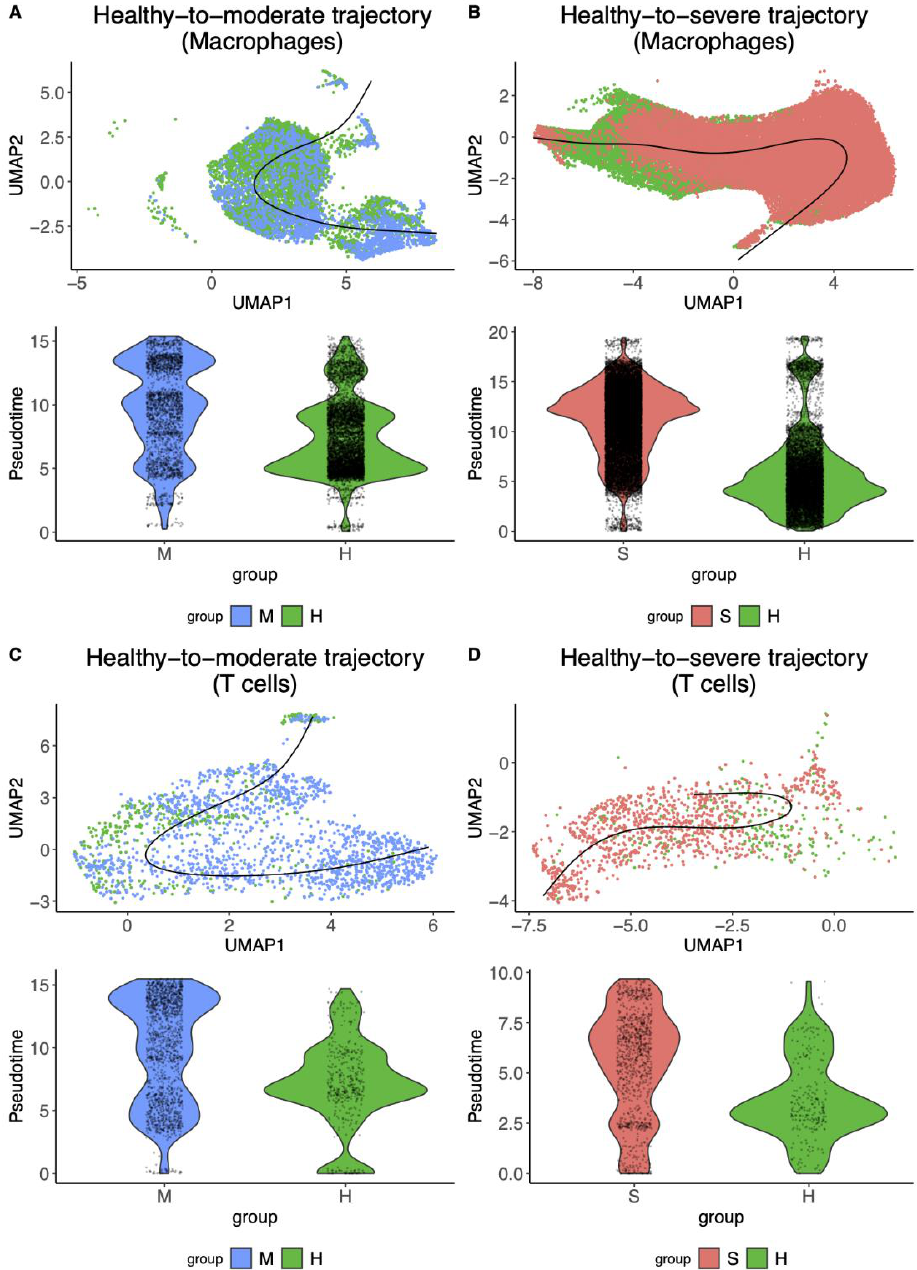
Figure 1. Cellular trajectories inferred by Slingshot in macrophages and T cells using Liao et al.’s BALF scRNA-seq data [9]. The illustrations of UMAP embedded cells (colored by the disease status) and inferred cellular trajectories (displayed as bold lines) (top). Violin plots show the pseudo time distributions of the inferred cellular trajectories for each disease group (healthy vs. moderate/severe) (bottom). ( A , B ) The cellular trajectories from healthy control cells to moderate or severe cells in macrophages. ( C , D ) The cellular trajectories from healthy control cells to moderate or severe cells in T cells. UMAP: Uniform Manifold Approximation and Projection. H, M, and S denote healthy, moderate, and severe samples, respectively.